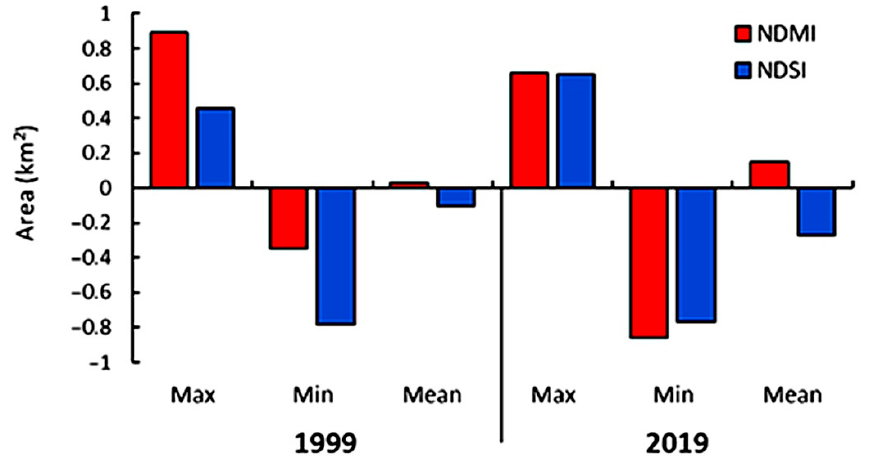
Figure 8. Statistics of the spectral retrieved parameters for Deltaic Mediterranean Coast of the study area.